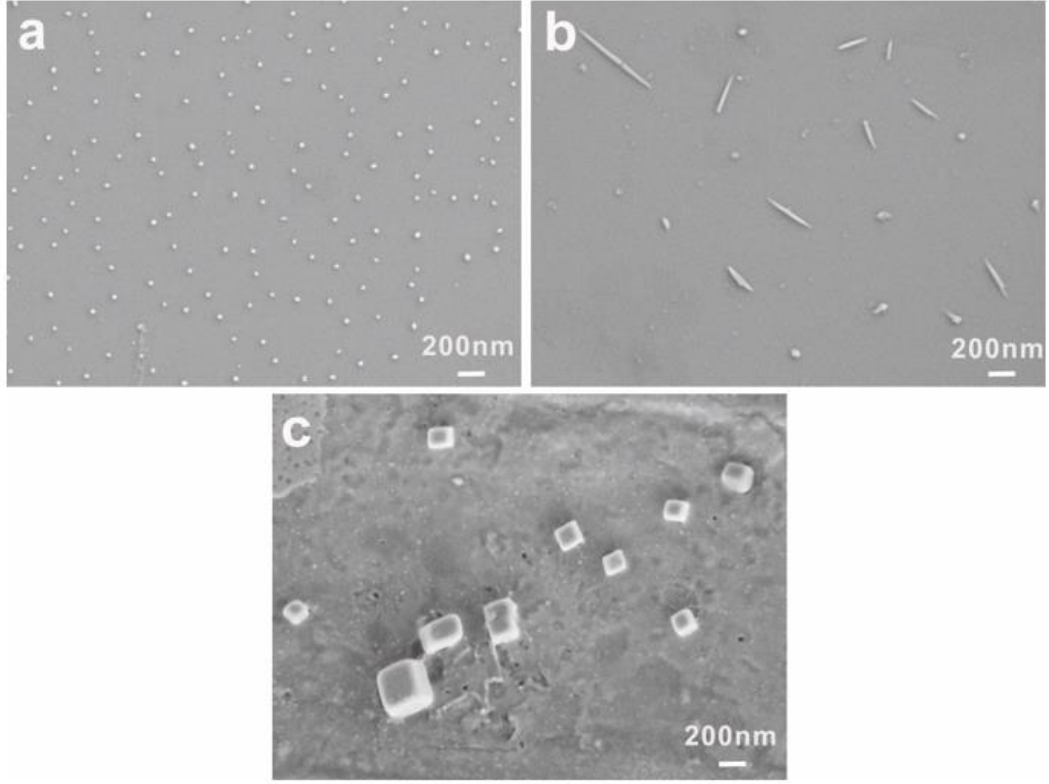
Figure 4. SEM images of 0.5 g L − 1 PEG-acrylic rosin polymer at 25 °C ( a ) 85 °C, ( b ) and 5 °C ( c ) respectively.